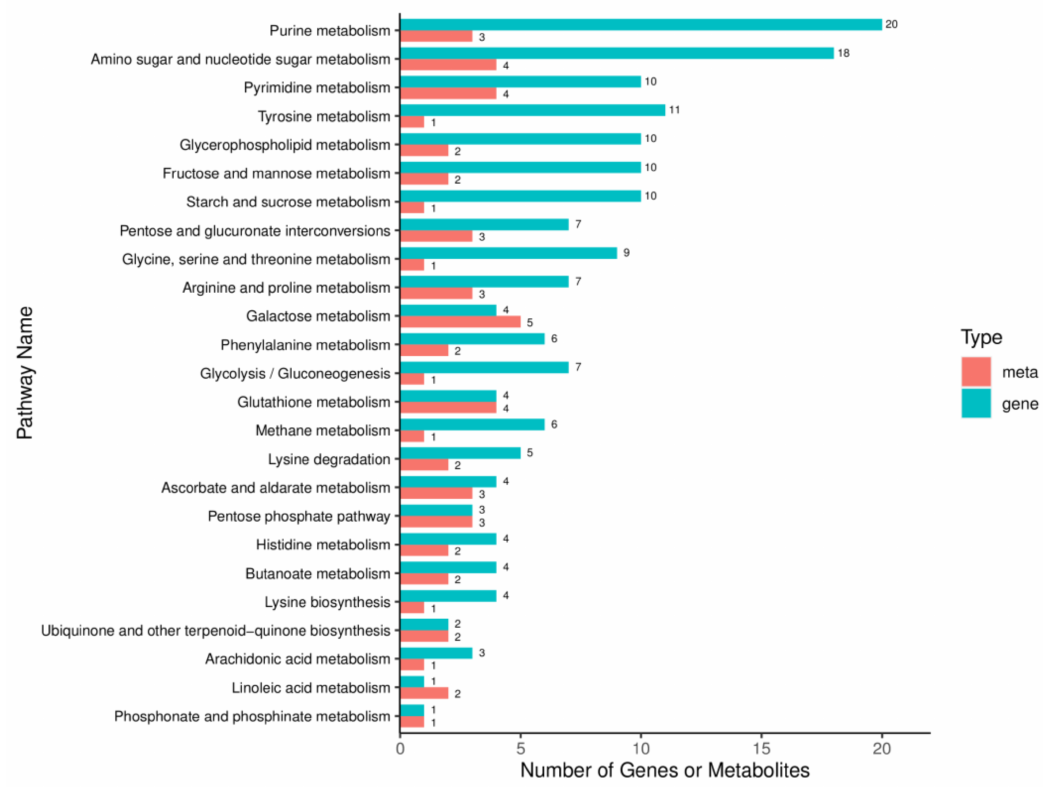
Figure 11. KEGG pathways significantly enriched in DEGs and